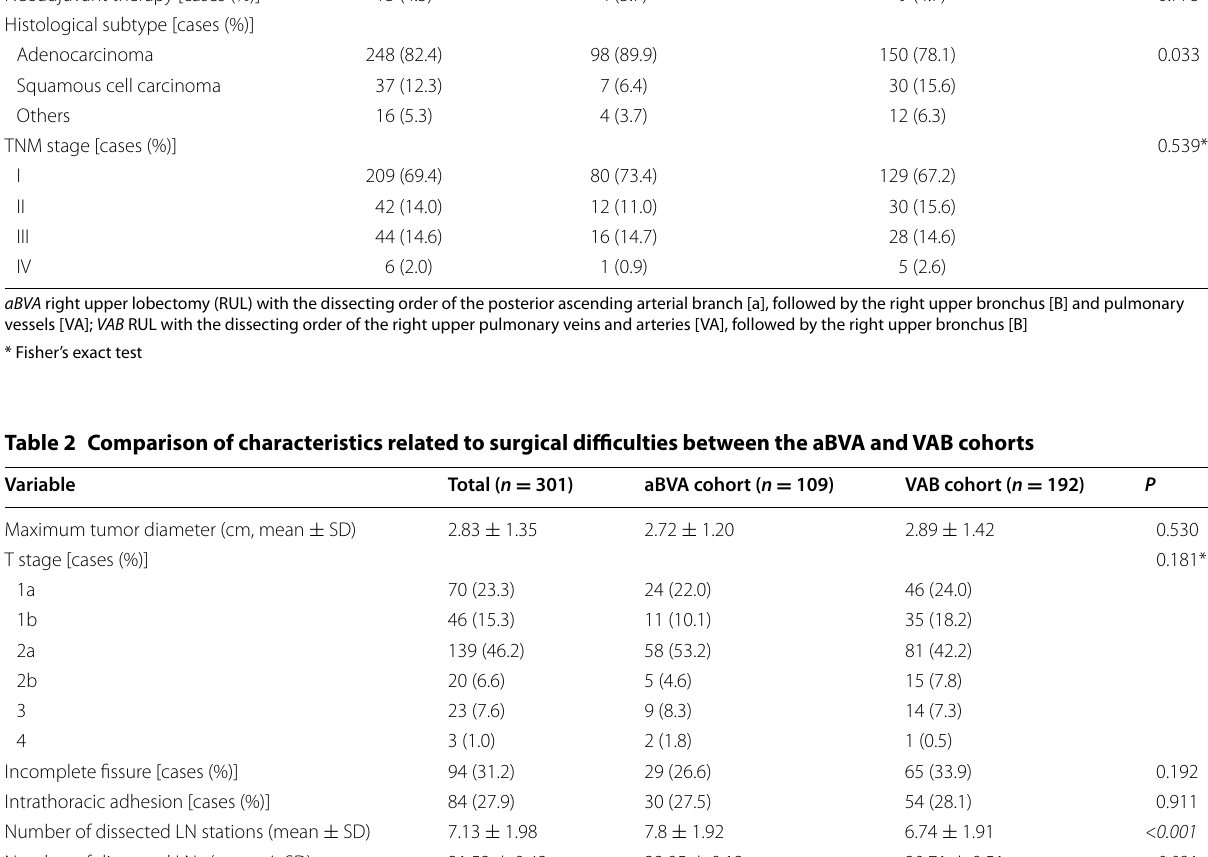
aBVA RUL with the dissecting order of the posterior ascending arterial branch [a], followed by the right upper bronchus [B] and pulmonary vessels [VA]; VAB RUL with the dissecting order of the right upper pulmonary veins and arteries [VA], followed by the right upper bronchus [B]; SD standard deviation; LN lymph